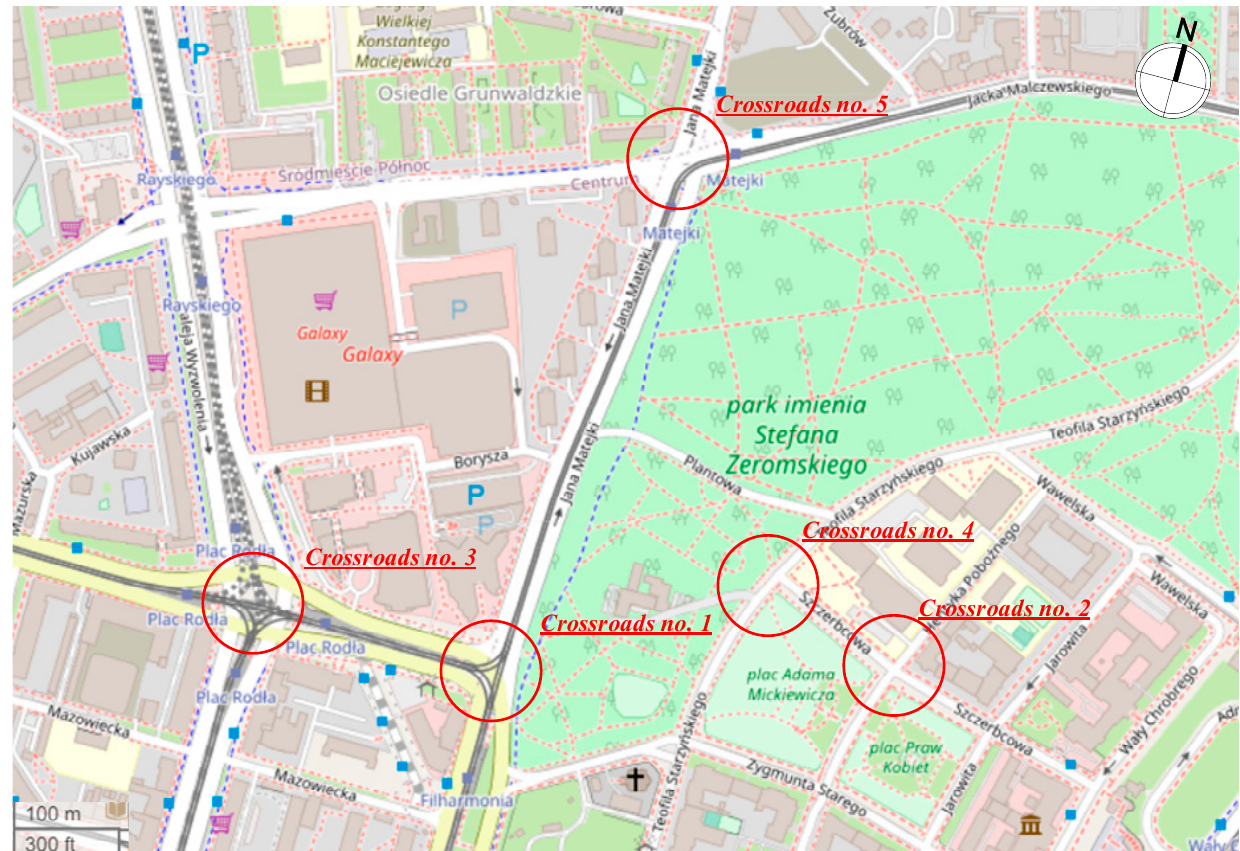
Figure 1. Location of key crosswalks (Five